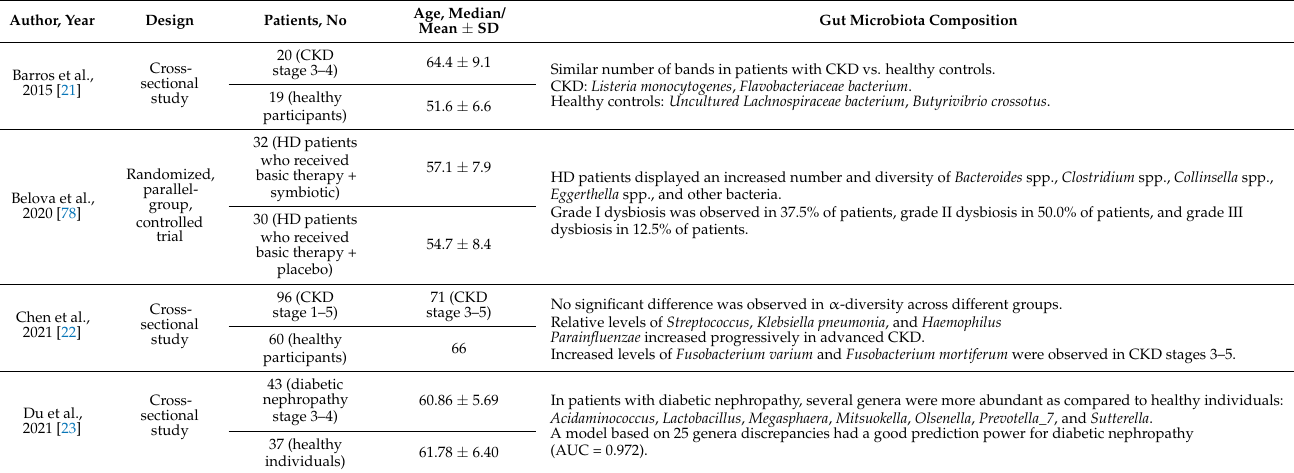
Table 1. Gut microbiota composition in CKD patients as reported in analyzed studies.